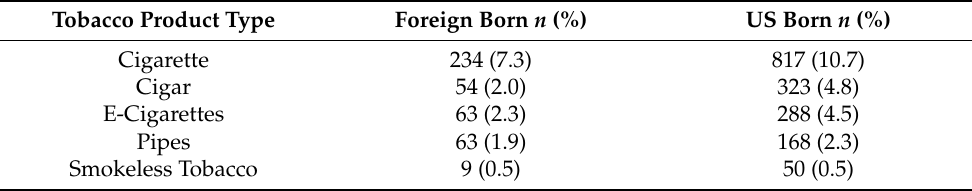
Table 2. Prevalence estimate of 5 tobacco products’ use by nativity status among young adults age 18–30, NHIS (2015–2019), n = 9907.